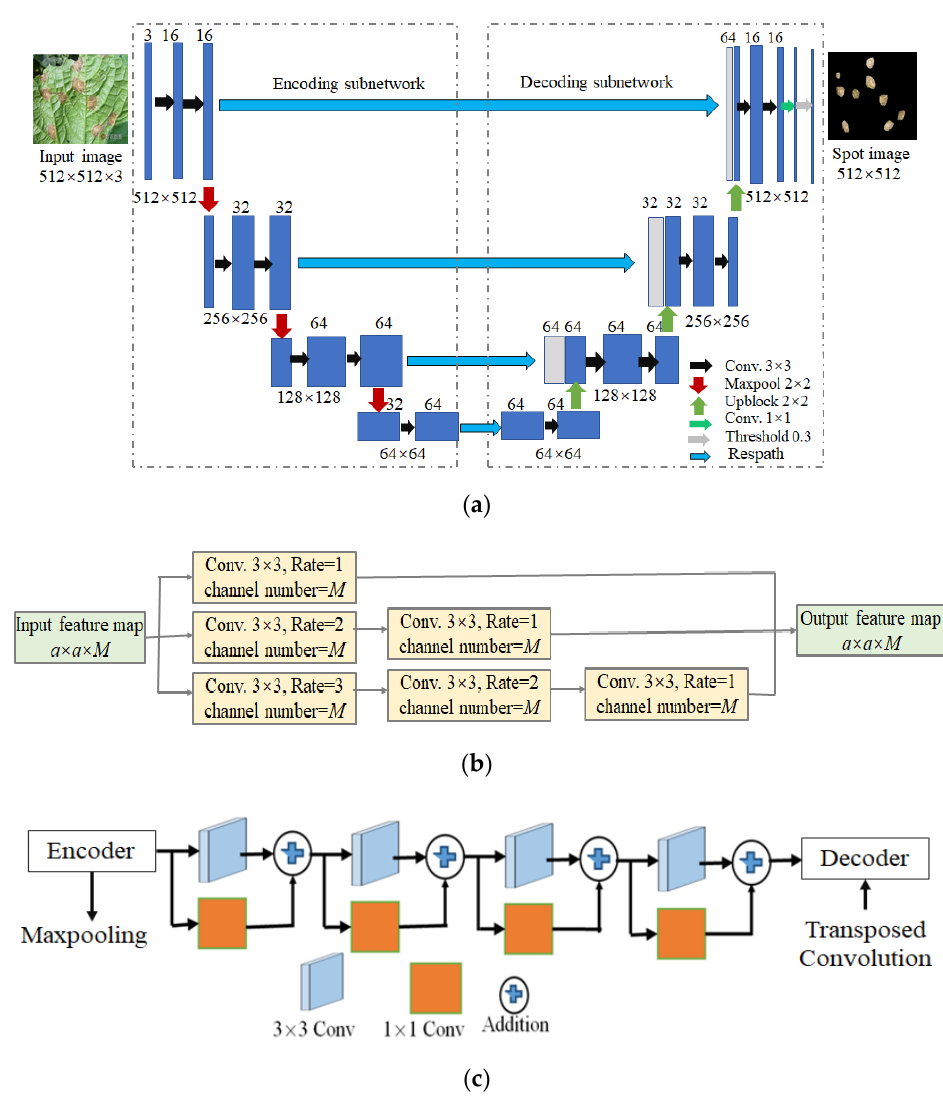
Figure 5. The architecture of LWMSDU-Net: ( a ) LWMSDU-Net structure; ( b ) dilated structure, where the size of the feature map is a×a , and M is the channel number; ( c ) Respath structure. The multi-scale dilated convolution is employed instead of the convolution of U-Net expansion rates r is set as 1, 2 and 3, respectively, so that the irregular disease regions of